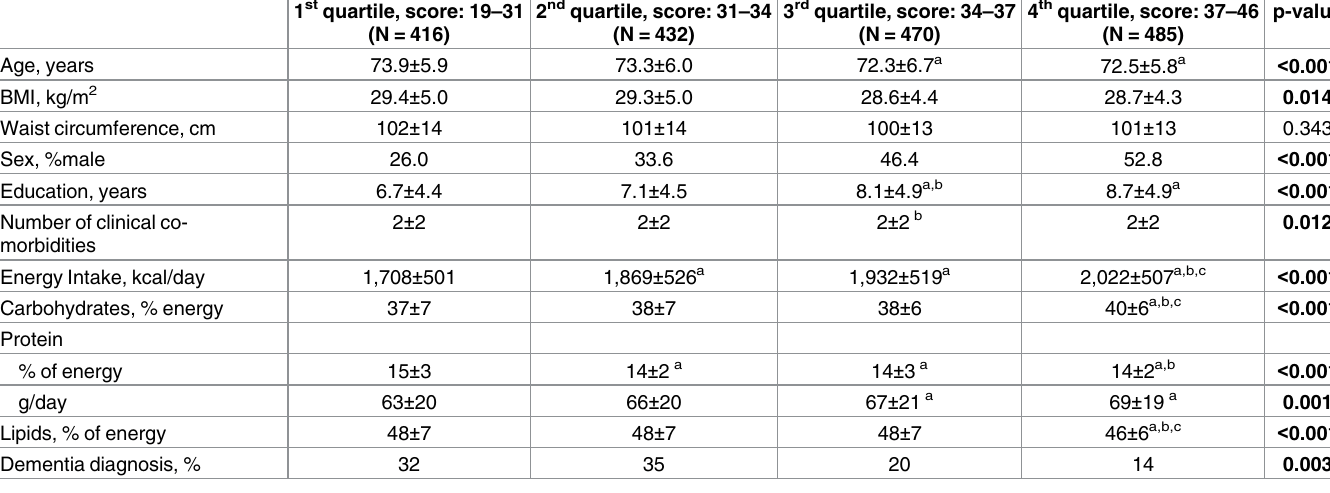
Table 2. Demographic, anthropometric, medical characteristics, dietary intake and cognitive status of the study participants by quartiles of the Mediterranean dietary